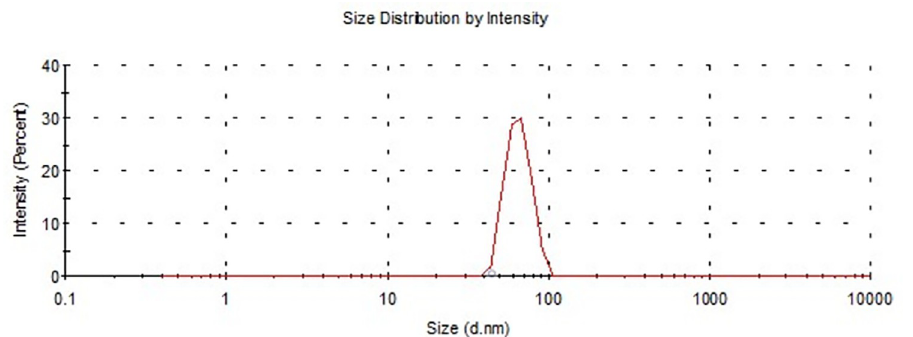
Fig 1. Size distribution of Eug-NE using a